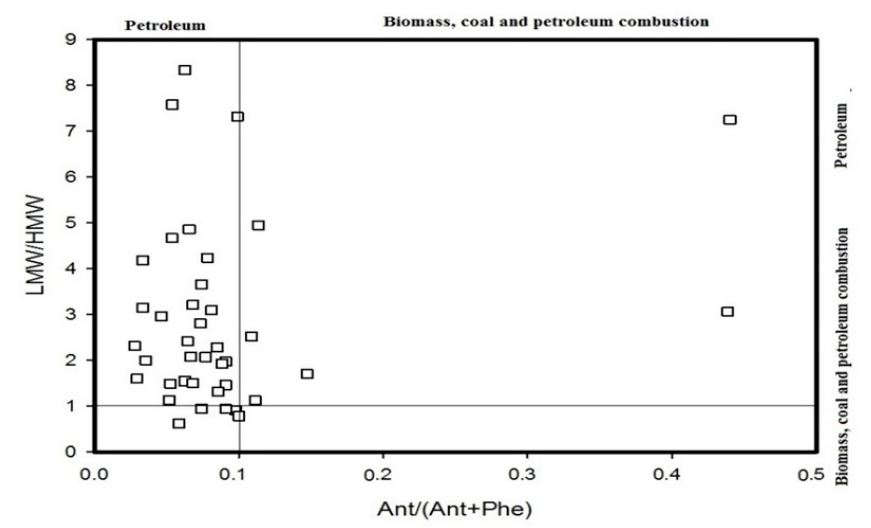
Figure 7. Source identifications of PAHs in soils of the Momoge Wetland (3).